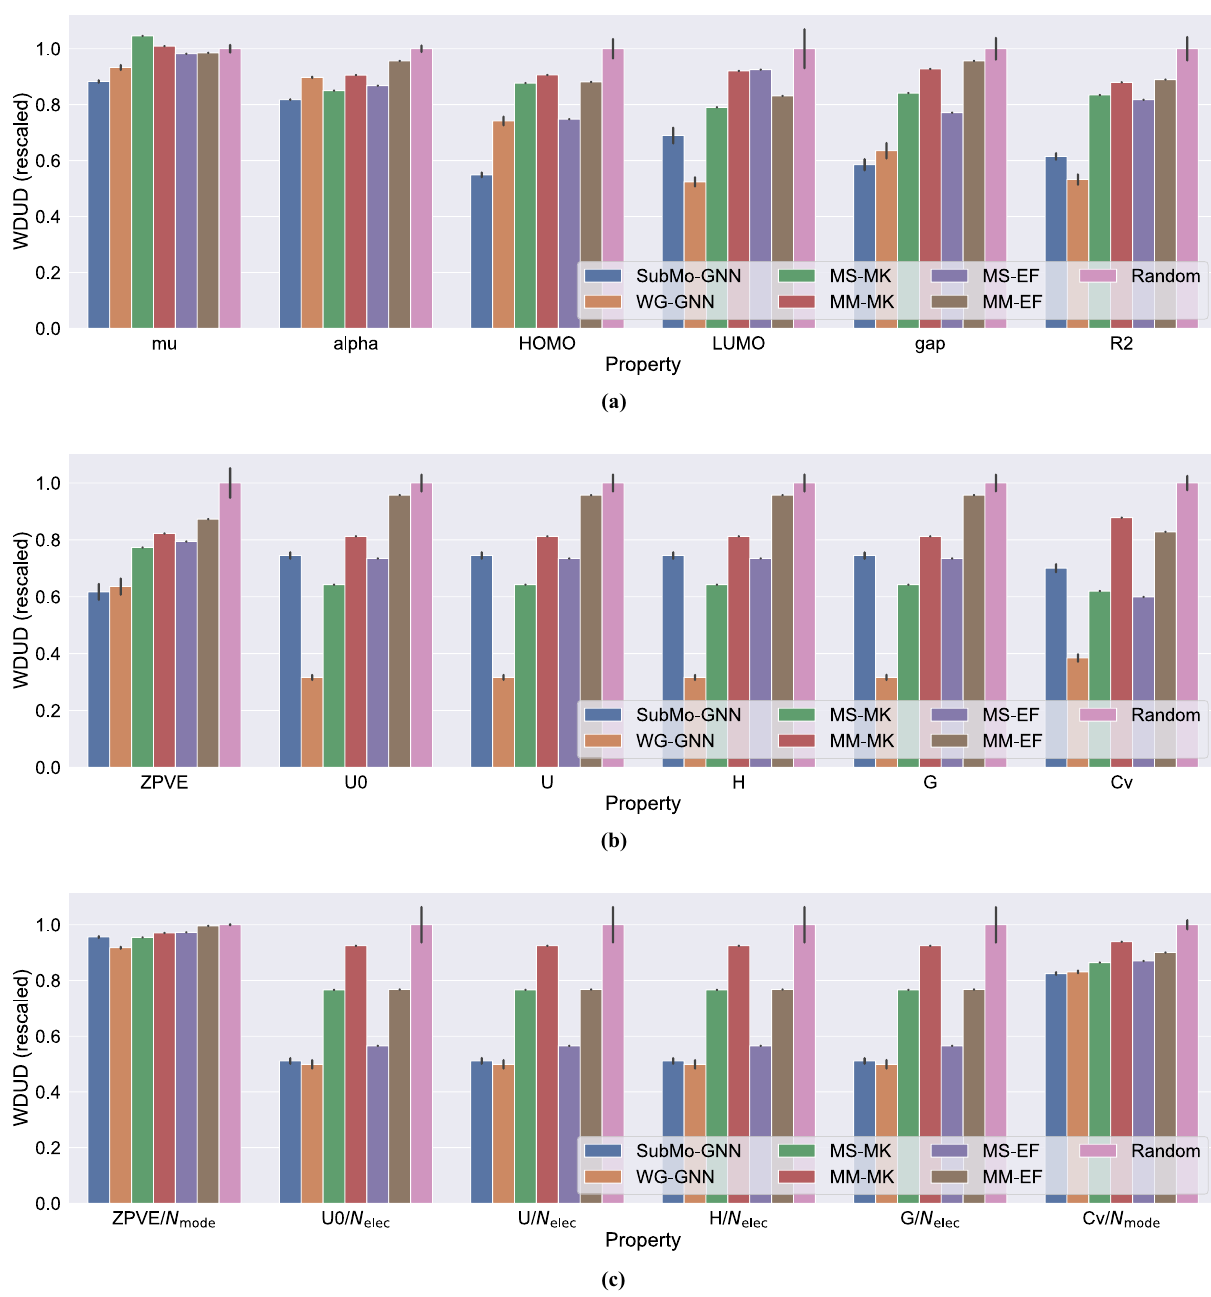
Figure 4. Bar charts of WDUD values. All the values are rescaled so that those of Random become 1. ( a ) Shows the results on the first six properties. ( b ) is the results on the six properties correlated with N elec or N mode (the WDUD values are computed with the raw property values). ( c ) is a modified version of ( b ), where the property values are divided by N elec or N mode for making those values capture subtle molecular characteristics such as connectivity